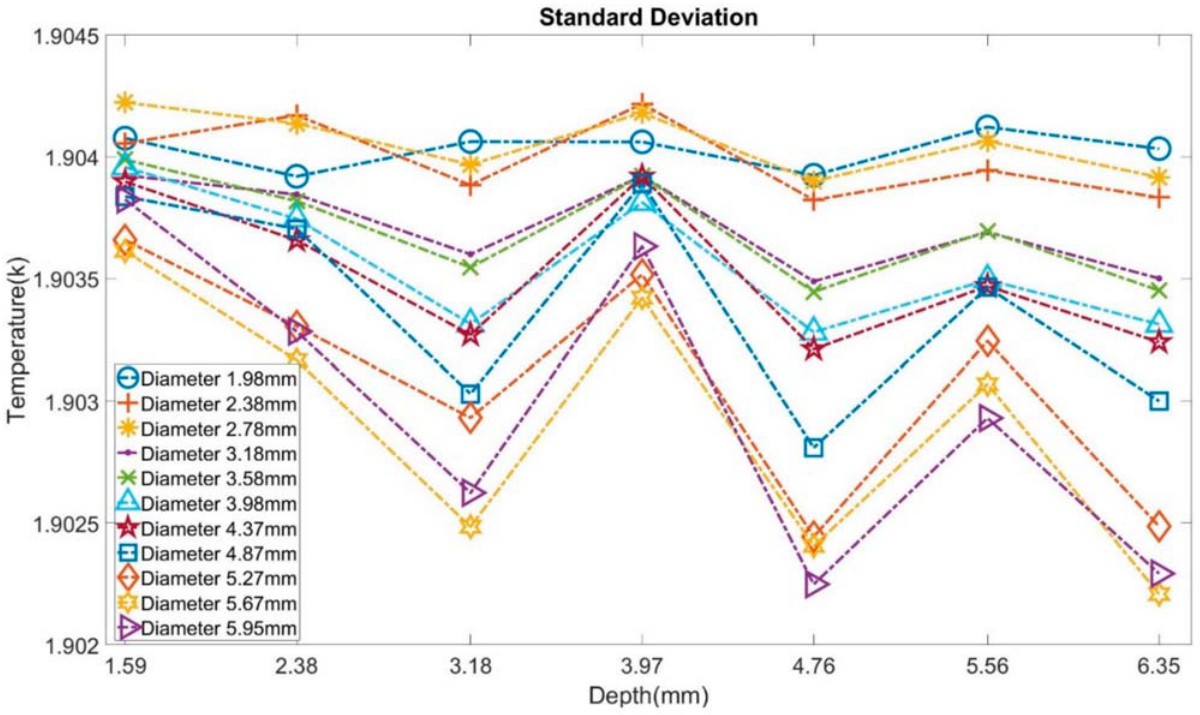
Figure 17. Standard deviation of temperature through the cooling process from all models.